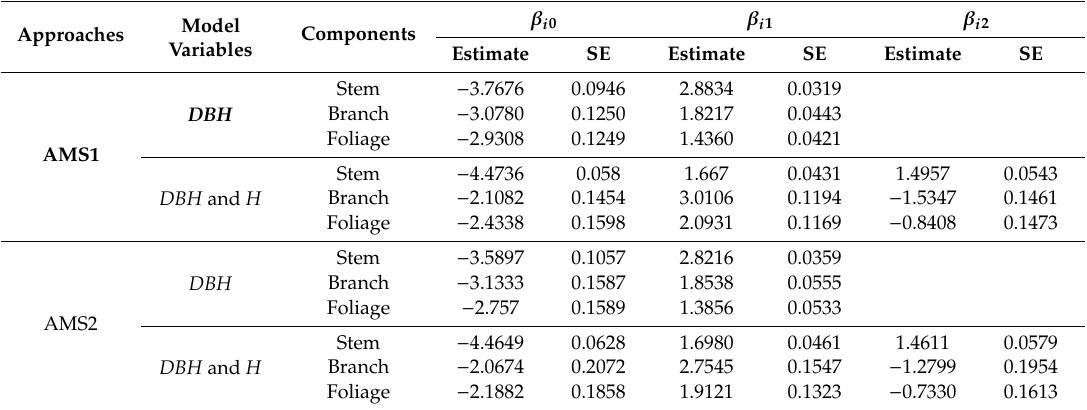
Table 3. Parameter estimates and their standard errors (SE) for the AMS1 [Equations (5) and (6)] and AMS2 [Equations (7) and